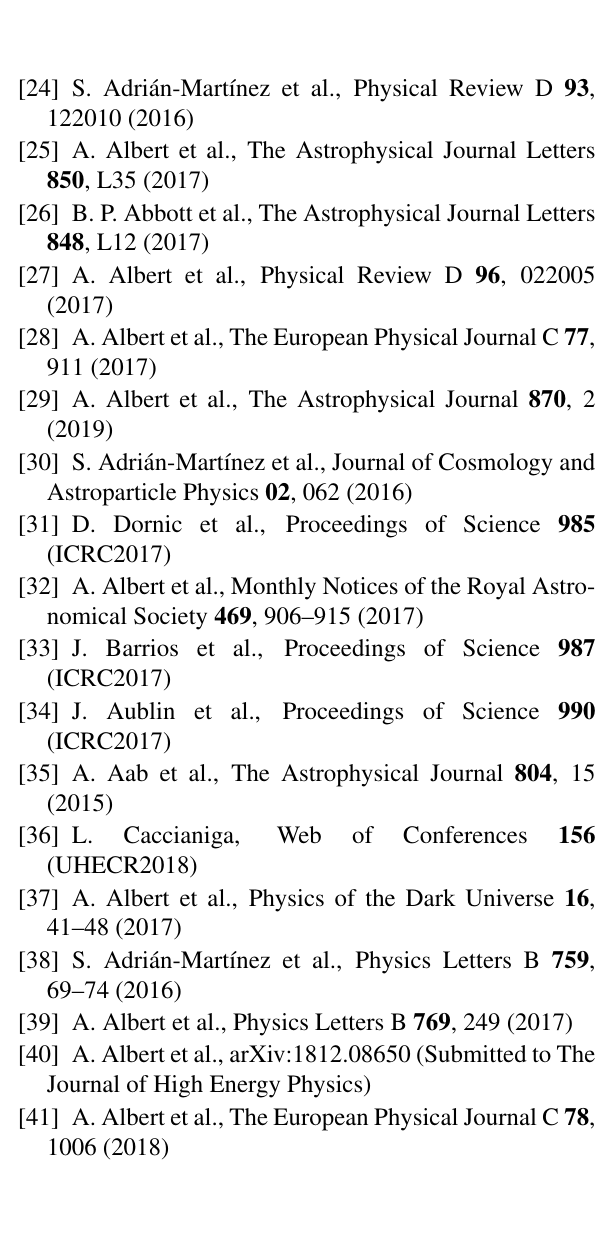
Figure 8. Left: ANTARES limits from the Milky Way on the thermally averaged annihilation cross-section, < σν > , as a function of the WIMP mass [39] compared to other experiment limits. Right: ANTARES limits on the spin-dependent WIMP-nucleon scattering cross-section as a function of WIMP mass for the b ¯ b , τ + τ − and W + W − channels from observations of the Sun [38] in comparison to limits of other